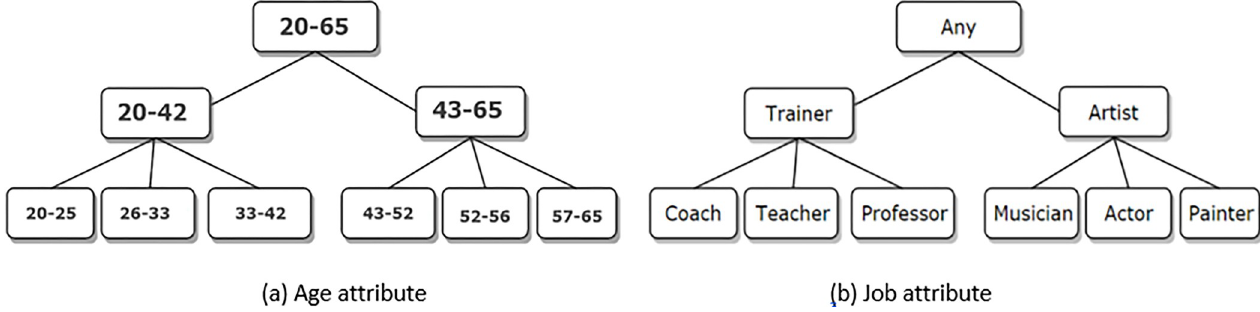
Fig 3. Generalization tree for age and job